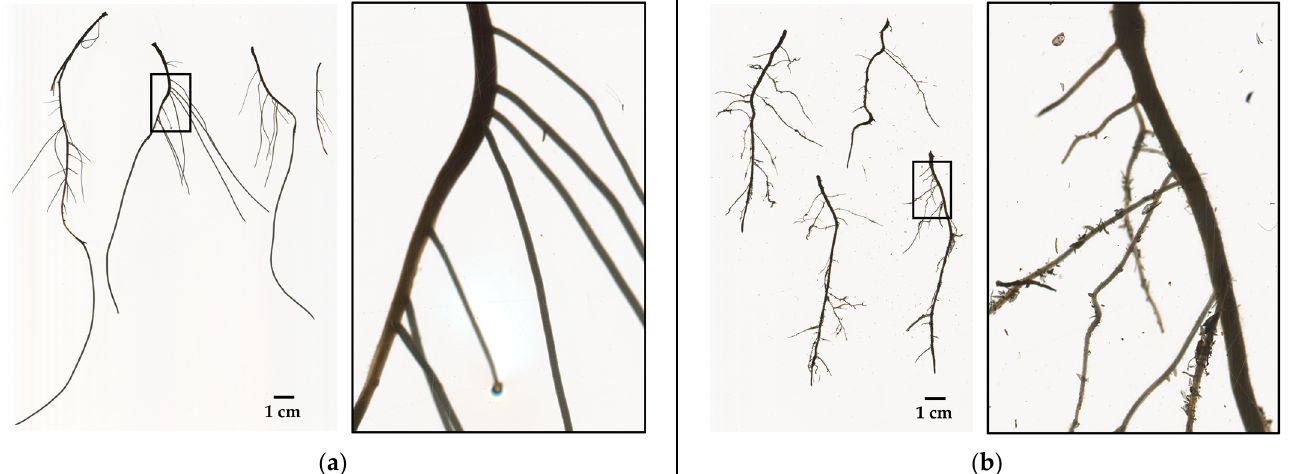
Figure 8. Samples of scanner-based images at 600 dpi (dots per inch). The bare root samples were of softwood cuttings from the backcross BC1256, treated with K-IBA at 0.1% ( w/v ), and rooted in one of the aeroponic systems ( a ) and in one of the germination trays ( b ).